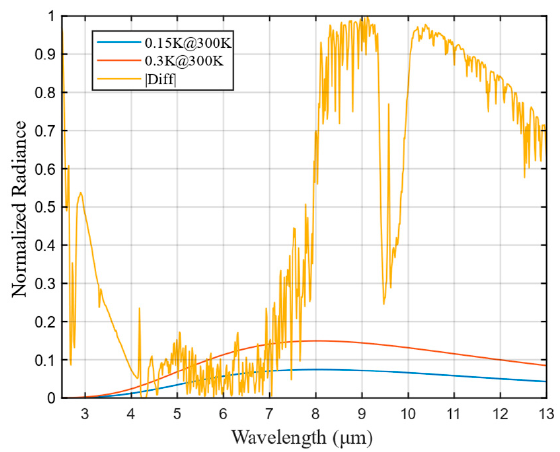
Figure 15. Comparison of noise equivalent radiance and radiance difference between target and background.